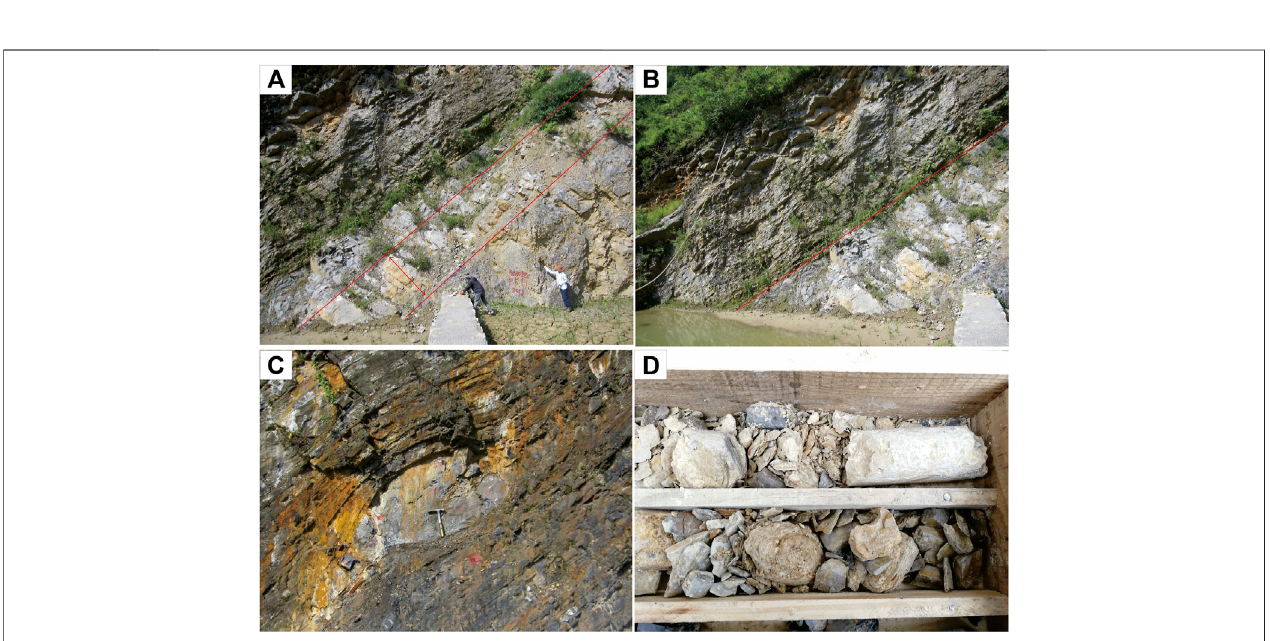
FIGURE 3 | Longfeng quarry section near Shangsi, Guangyuan.